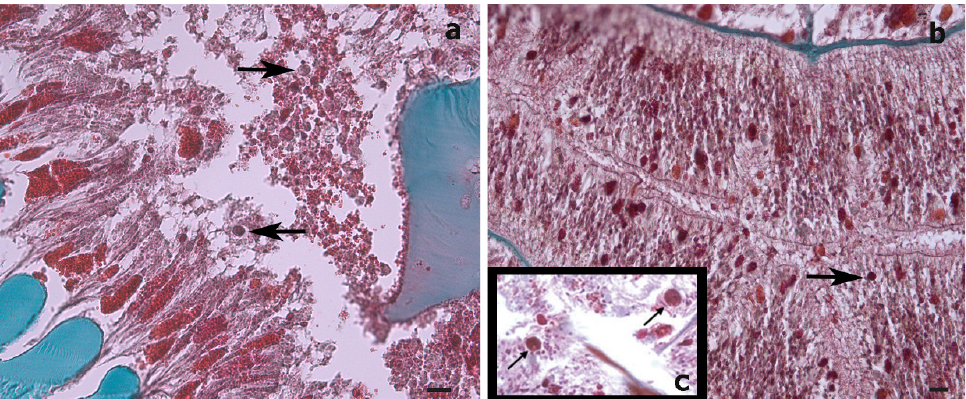
Figure 4. Histological cross-sections of a Stichopathes maldivensis polyp. Symbiodiniaceae-like cells (arrows) are observed in the gastrodermis of the gastrovascular cavity ( a ) and in the gastrodermis of a lateral tentacle ( b ). ( c ) Inset for comparison is an image from Wagner et al. (2011, Figure 2c) in which Symbiodiniaceae cells were identified through histological ex-